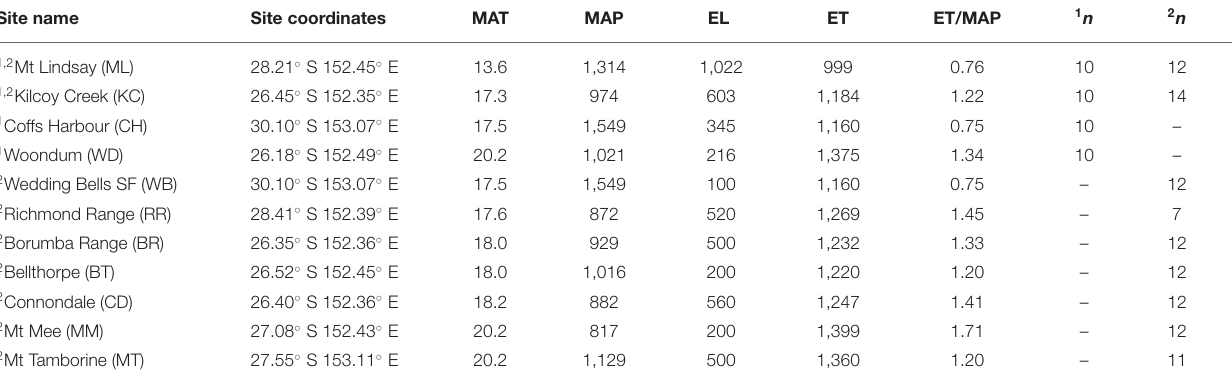
TABLE 1 | Location and climate variables characterizing the origin of E. grandis seed provenance for Experiment 1 ( n = 40) and Experiment 2 ( n = 104); see superscript